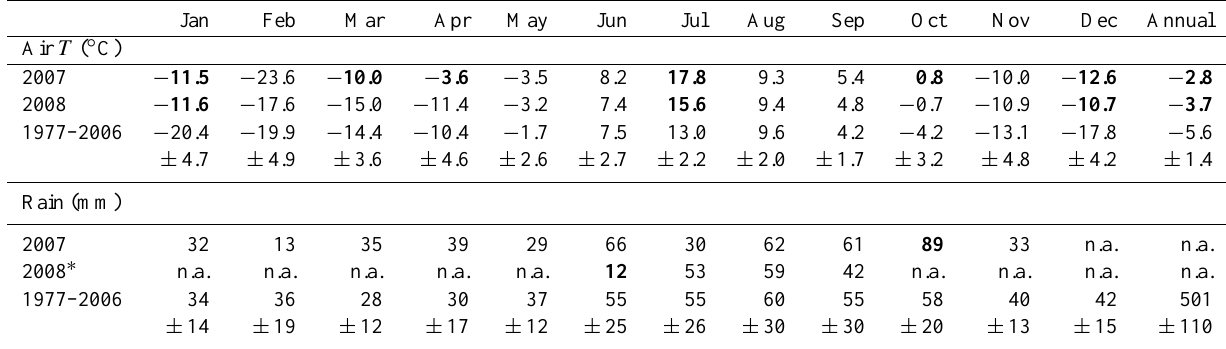
Table 1. Monthly mean air temperatures and precipitation in 2007–2008 and long-term mean ± SD at Vorkuta meteorological station (67 ◦ 48 0 N, 64 ◦ 01 0 E, 172ma.s.l.). Data from Komi Republican Center for Hydrometeorological and Environmental Monitoring. Monthly values significantly differing from the long-term means are shown in bold.